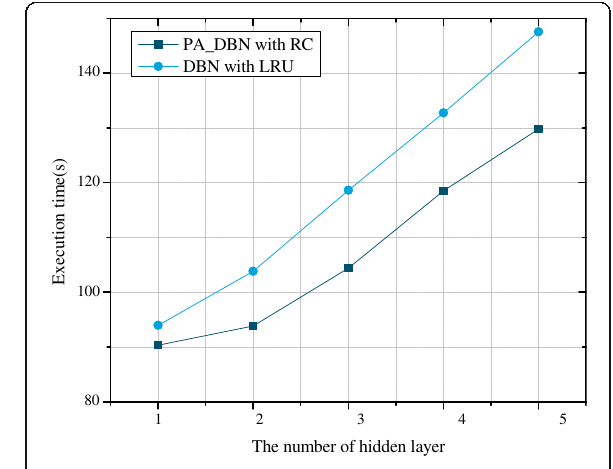
Fig. 5 The comparison by taking RDD cache